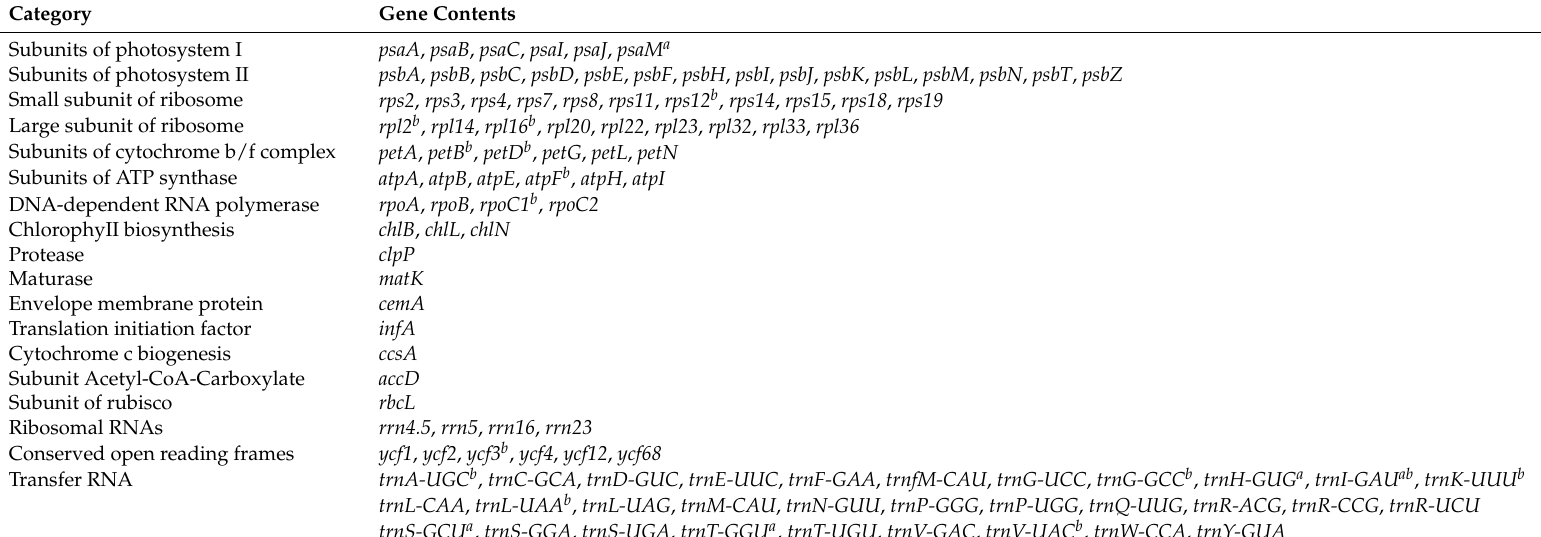
Table 1. Gene contents of P.massoniana chloroplast genome based on genome